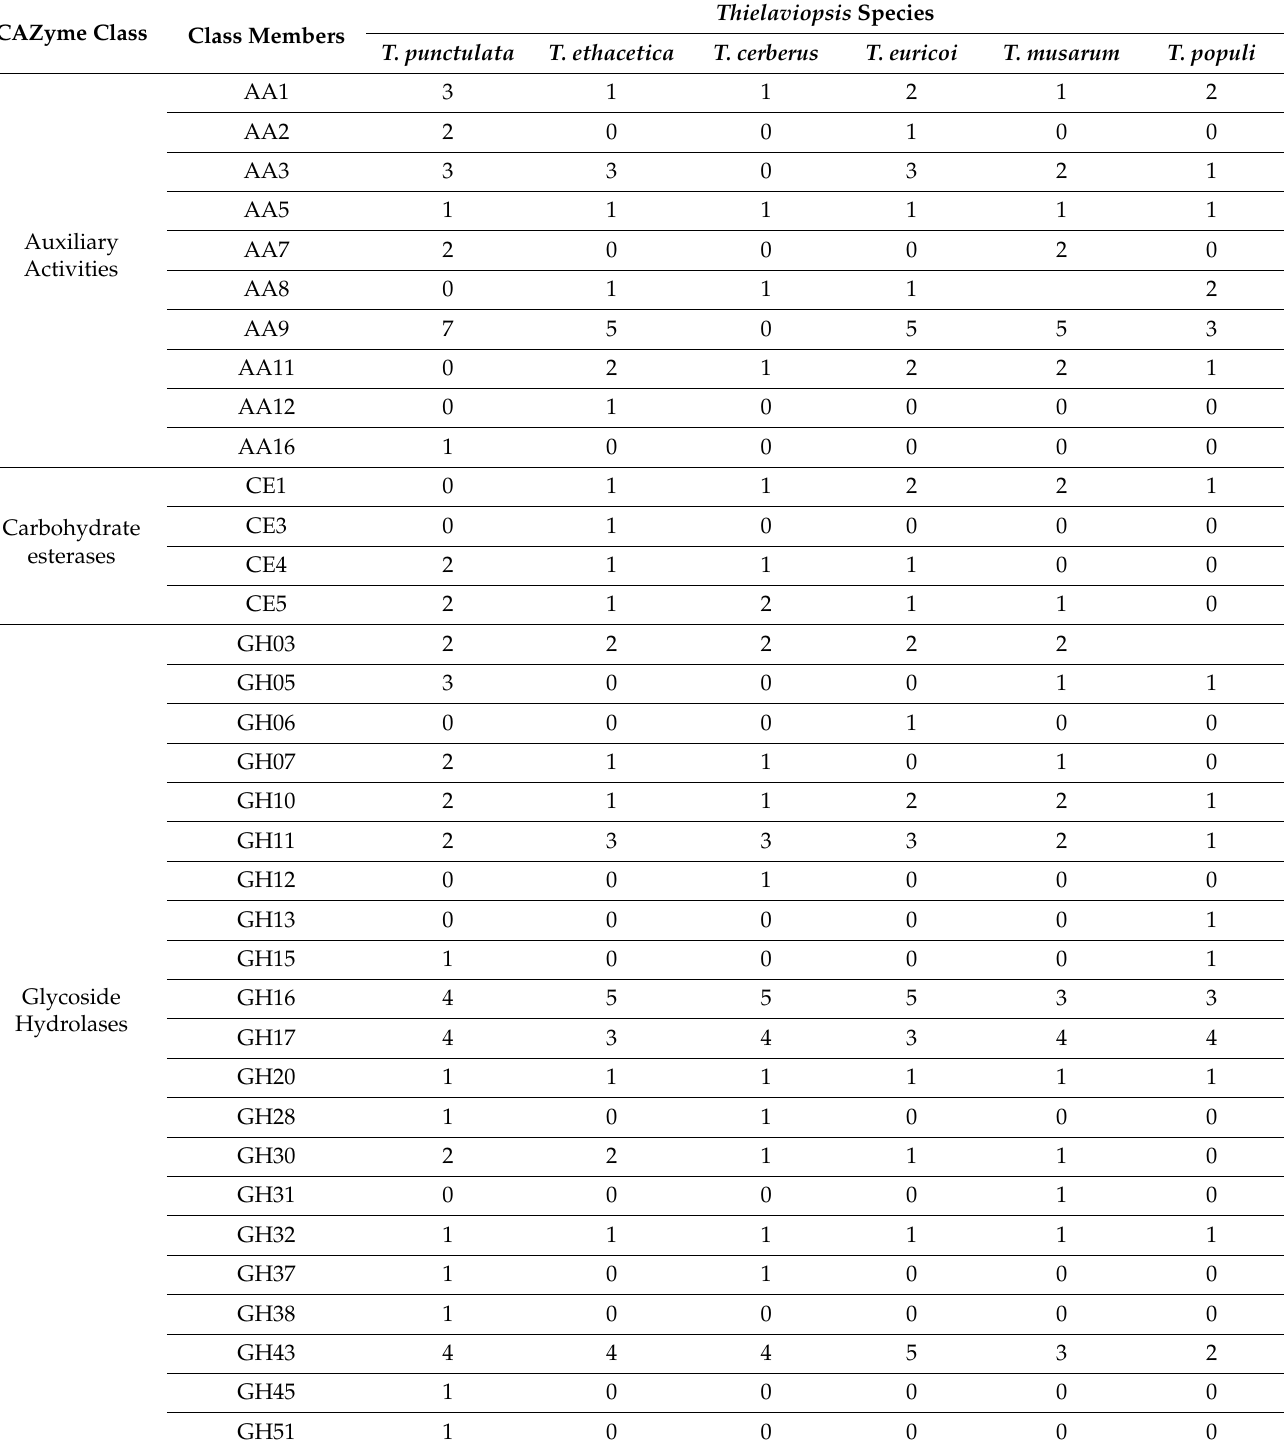
Table 3. Comparison of CAZymes in the secretome of six Thielaviopsis